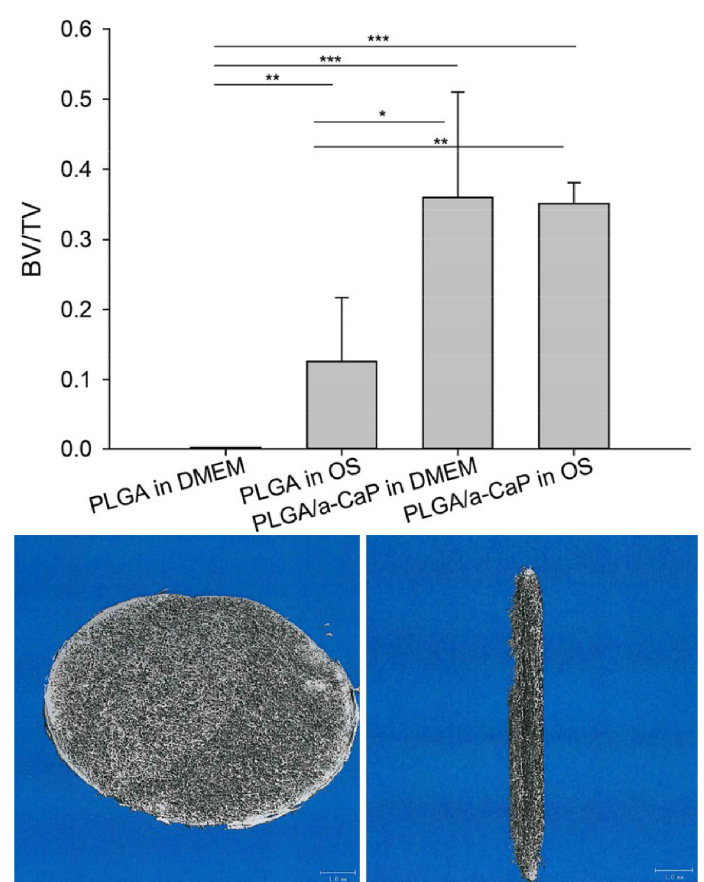
Figure 7. The bone volume (BV)/total volume (TV) (= bone volume fraction) is given for the two different materials (PLGA and PLGA/aCaP) in the two different culture media (DMEM and osteogenic medium = OS). The bone volume fraction (BV/TV) was assessed for the ASC-seeded three- dimensional random fiber meshes after 14 days cultured in vitro (see Materials and Methods). Below, there are typical micro-CT images of a PLGA scaffold: surface (left) and cross-section (right), scale bars = 1 mm. The p -values of pairwise comparison of one-way ANOVA statistics were considered significant if p < 0.05, denoted by *. **, p < 0.01; ***, p <